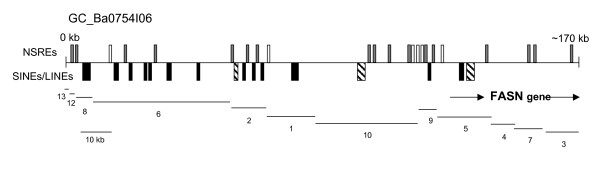
NSRE1 (top, gray box) and NSRE2 (top, open box) were mapped on the draft sequence of the BAC clone GC_Ba0754I06 along with SINEs/LINEs (bottom, hatched box) and CR1-like SINEs/LINEs (bottom, black box). Transcriptional orientation of a partial fatty acid synthase (FASN) gene, including at least 27 exons, is marked with arrows from 5' to 3' direction. Contigs and their numbers are shown under the map. A 10 kb scale is shown on the left bottom.